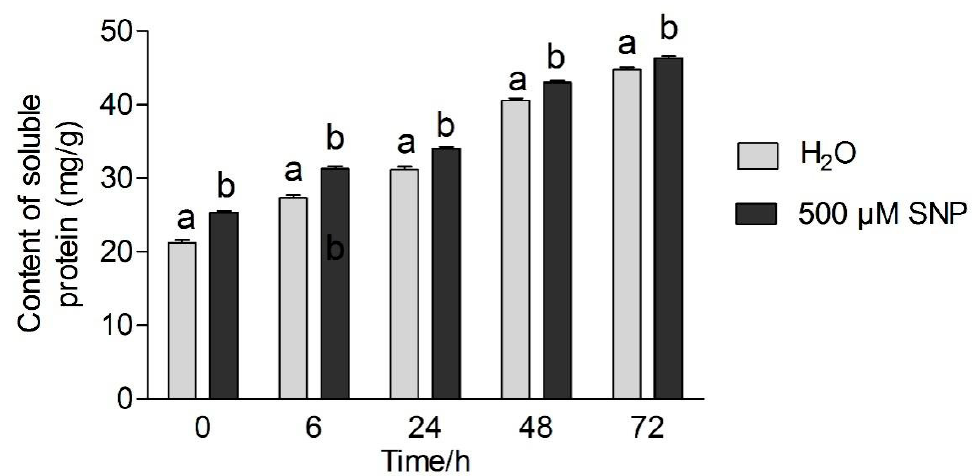
Figure 4. Effect of exogenous nitric oxide on soluble protein content in tea leaves under cold stress.